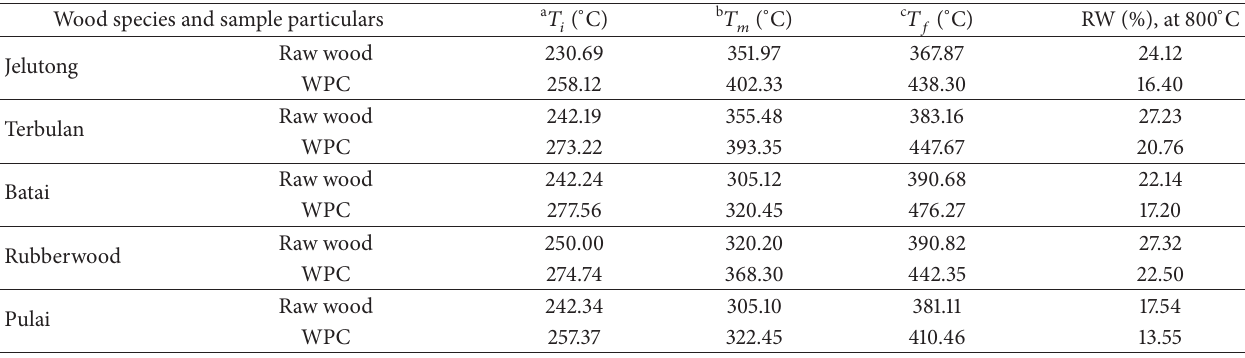
Figure 3: Typical SEM micrographs of Jelutong (a) raw wood and (b) WPC sample. Table 1: TGA results of raw wood and WPC samples.